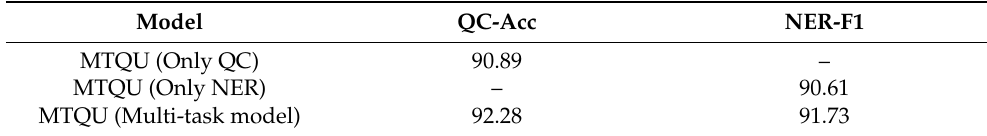
Table 4. Multi-task Model vs. Individual Models.